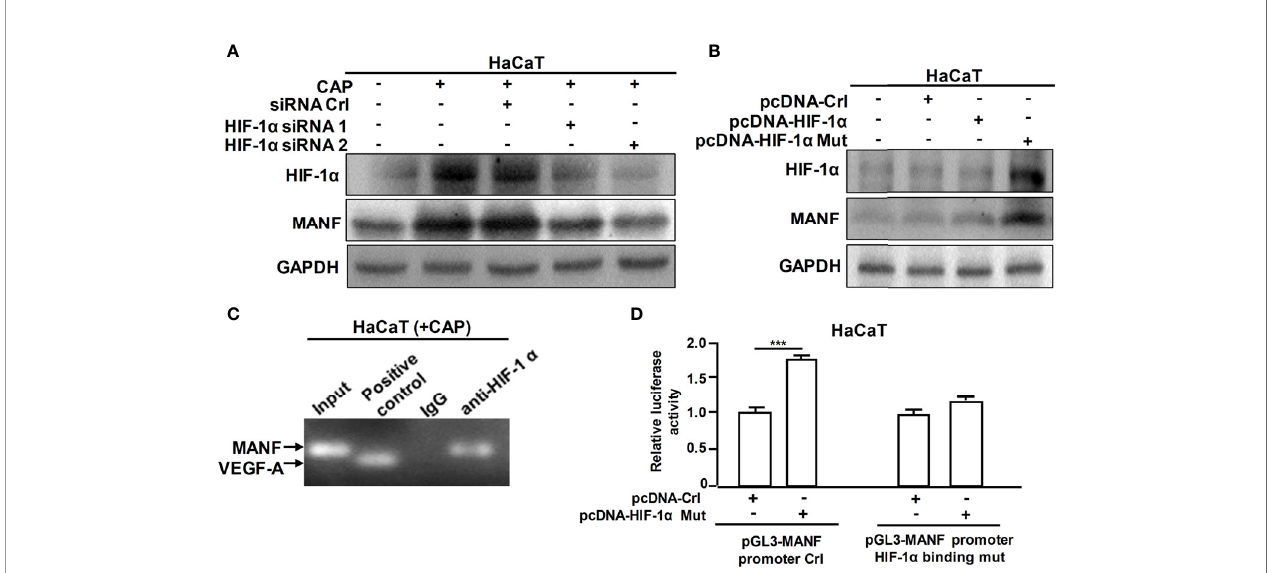
FIGURE 5 | CAP induced MANF transcription and expression by HIF-1 a -mediated transcriptional regulation. (A) HaCaT cells transfected by siRNA control, HIF- 1 a siRNA 1 and HIF-1 a siRNA 2 respectively were treated by CAP, followed by western blot of HIF-1 a and MANF. (B) HaCaT cells transfected by pcDNA- control, pcDNA-HIF-1 a and pcDNA-HIF-1 a mutation plasmid respectively were treated by CAP, followed by western blot of HIF-1 a and MANF. GAPDH serves as control for normalization. (C) HaCaT cells treated by CAP were used for Chromatin Immunoprecipitation assay. HIF-1 a antibody was used for HIF-1 a protein immunoprecipitation. IgG antibody serves as negative control. VEGF-A was involved as a positive control for HIF-1 a binding. (D) HaCaT cells transfected by pcDNA-control and pcDNA-HIF-1 a mutation plasmid respectively were used for dual-luciferase reporter assay of pGL3-MANF promoter control or pGL3-MANF promoter HIF-1 a binding site mutation plasmid. The relative luciferase activity was analyzed. All experiments were performed independently at least three times. Data are expressed as mean ± SEM. ***p <